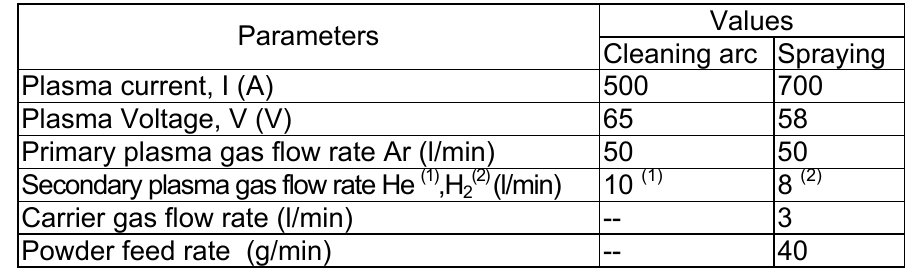
Table 1 – Vacuum plasma spray parameters Таблица 1 – Параметры ваккумного плазменного напыления Табела 1 – Вакуум - плазма - спреј